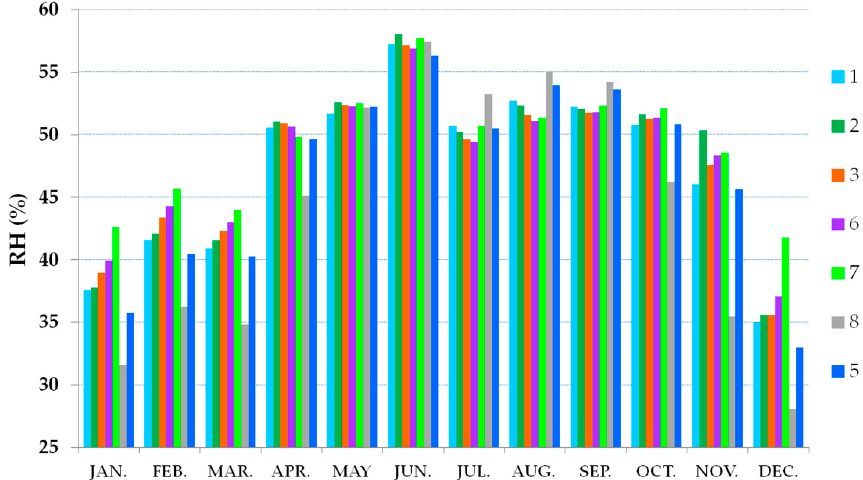
Figure 8. Monthly relative humidity (RH) averages recorded at the monitoring points.